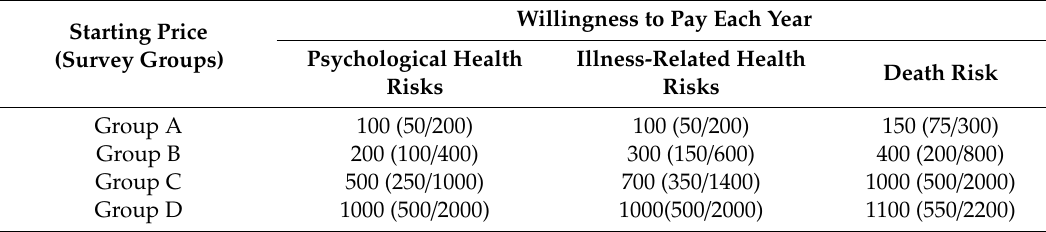
Table 1. Double-bounded dichotomous choice; payment and inquiry amount.